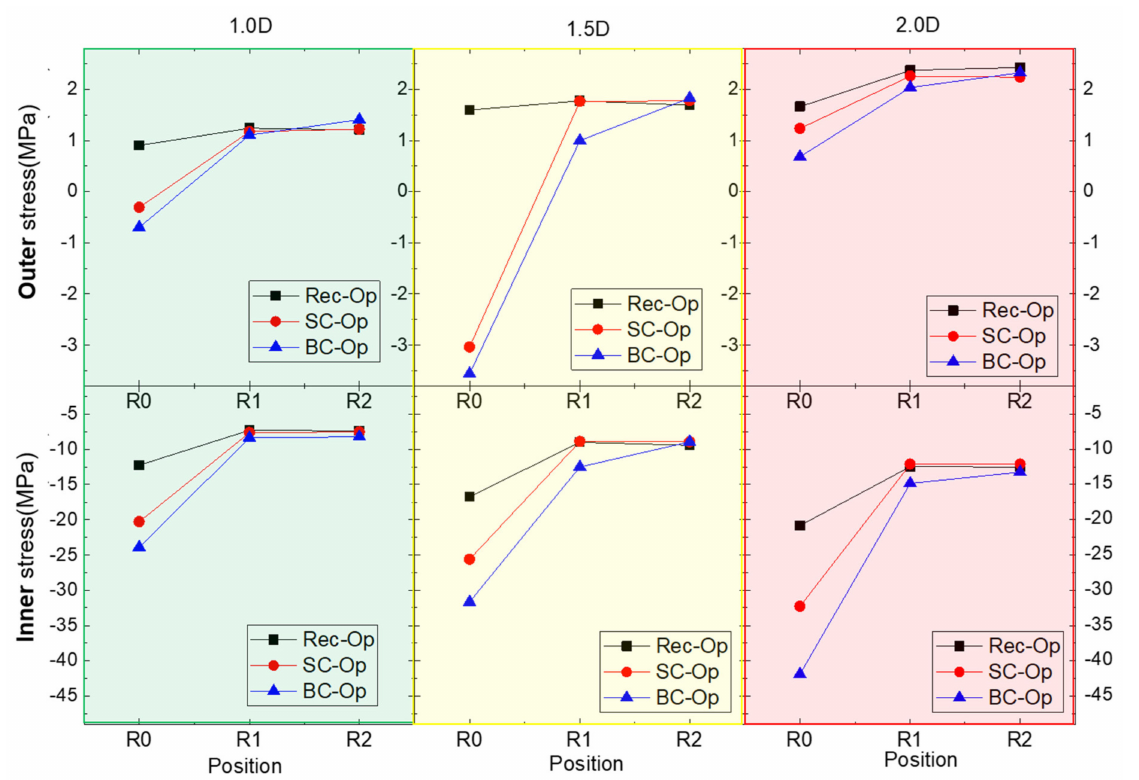
Figure 13. Variations of the structural